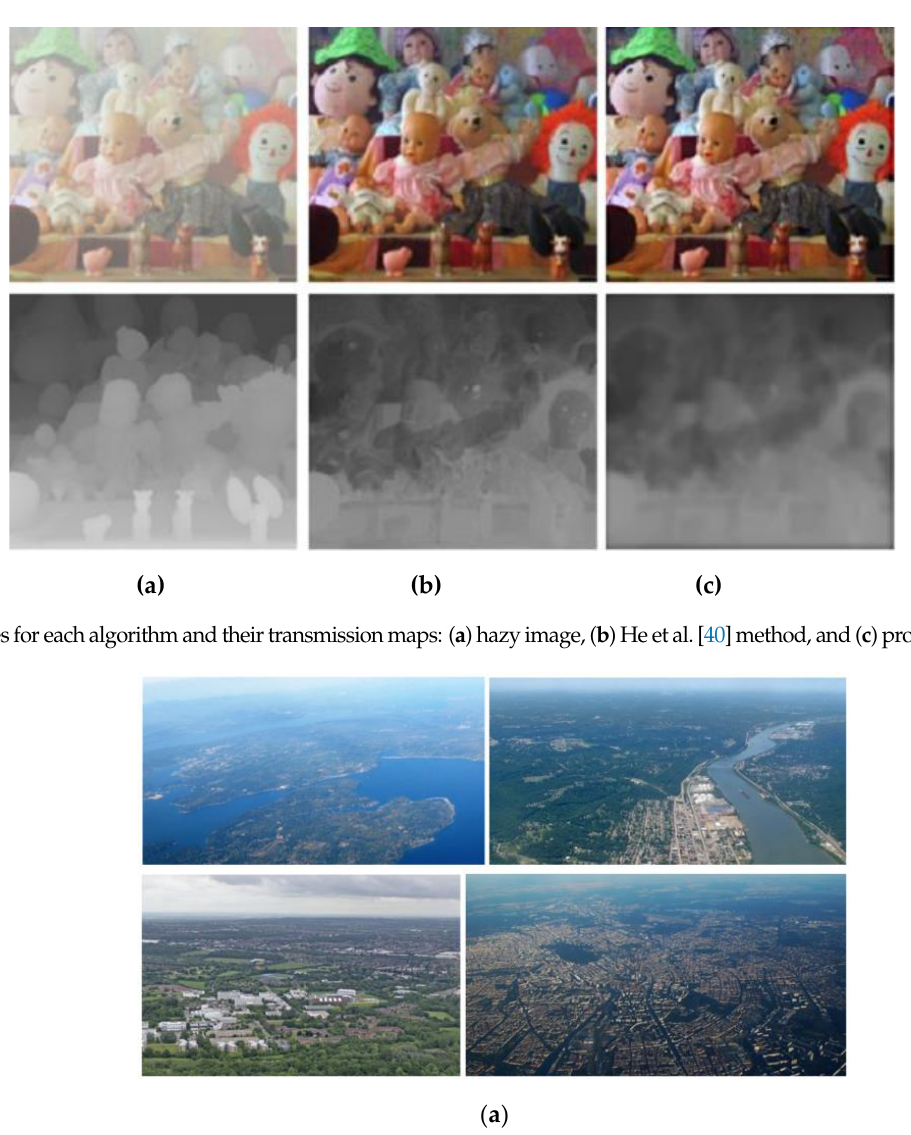
Figure 4. Results of several algorithms for aerial images. ( a )